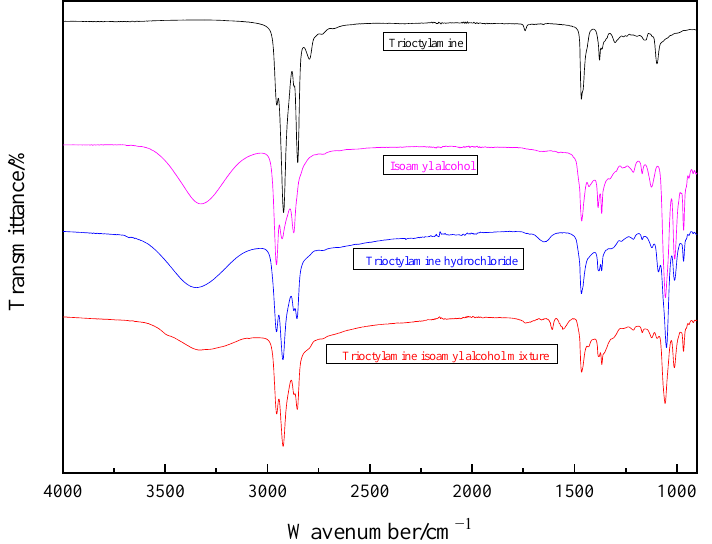
Figure A1. FT-IR spectra of R 3 N, isoamyl alcohol, R 3 N · HCl, and the mixture of R 3 N and isoamyl alcohol.